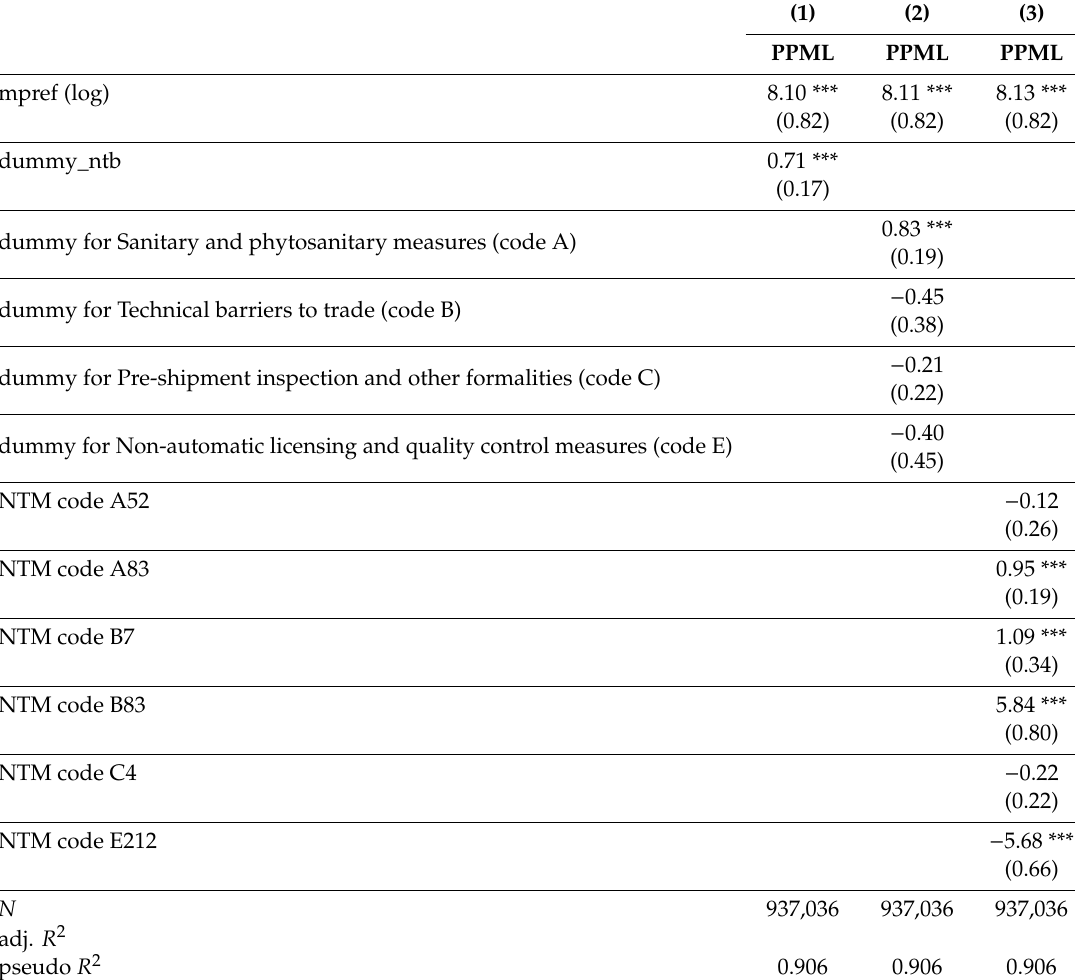
Table 4. Impact on the intensive margin of